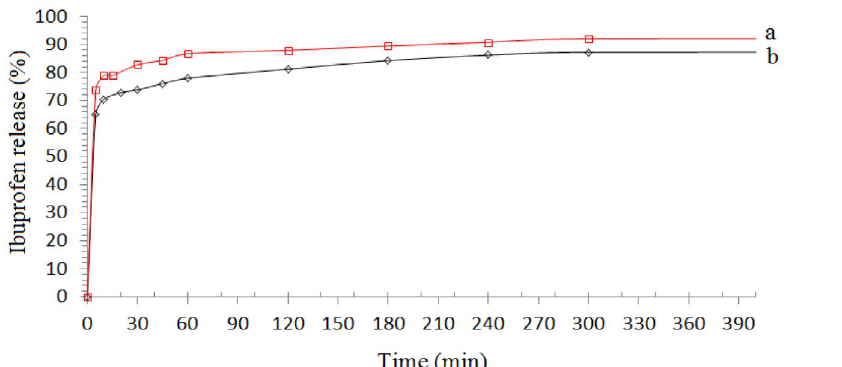
Fig. 5. Release profiles for 25 and 50% 25% ibuprofen supported γ-alumina in SBF (a) γ-Al-IBU25 and (b)